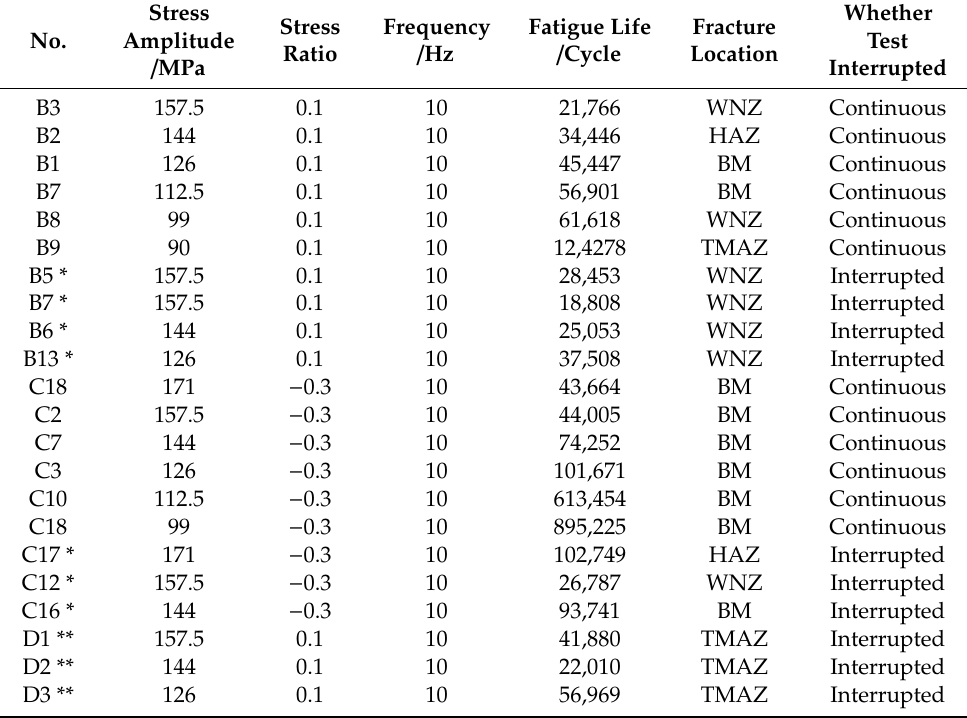
Table 4. Continuous and interrupted fatigue test data for FSW